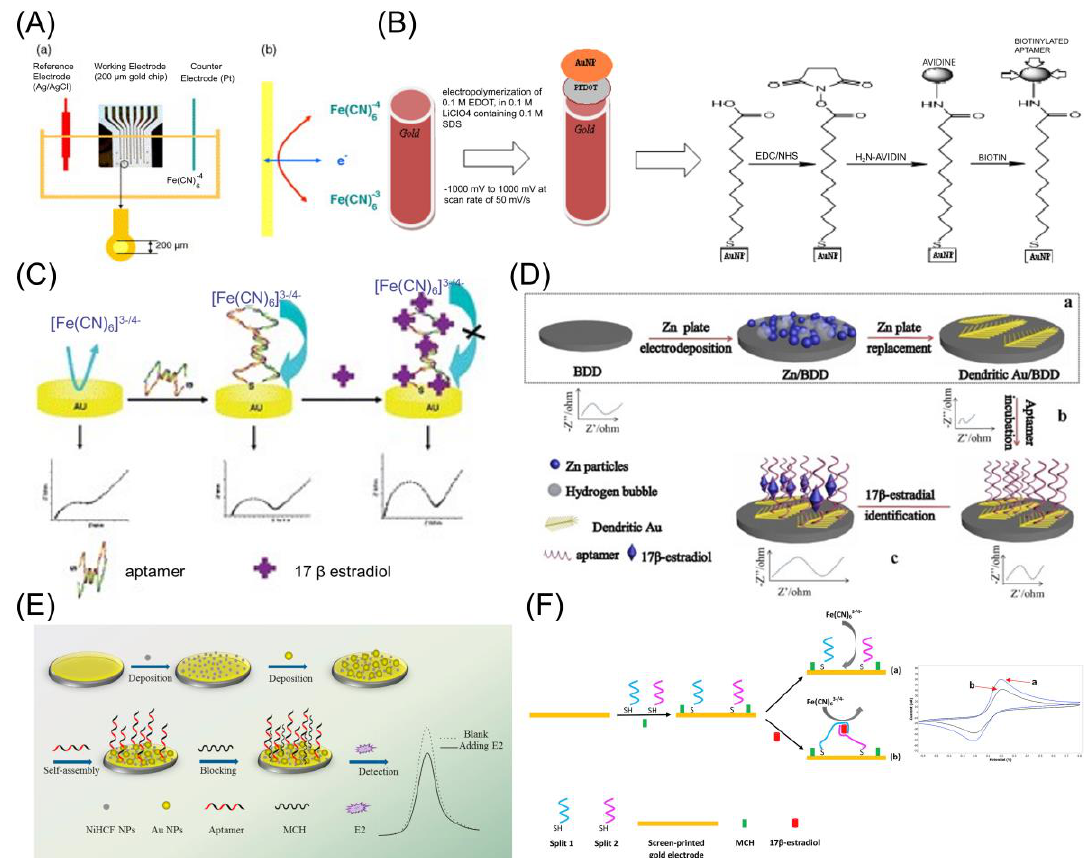
Figure 8. Electrochemical aptasensors based on gold electrode platforms for E2 detection. The gold- Figure 8. tion. aptamer